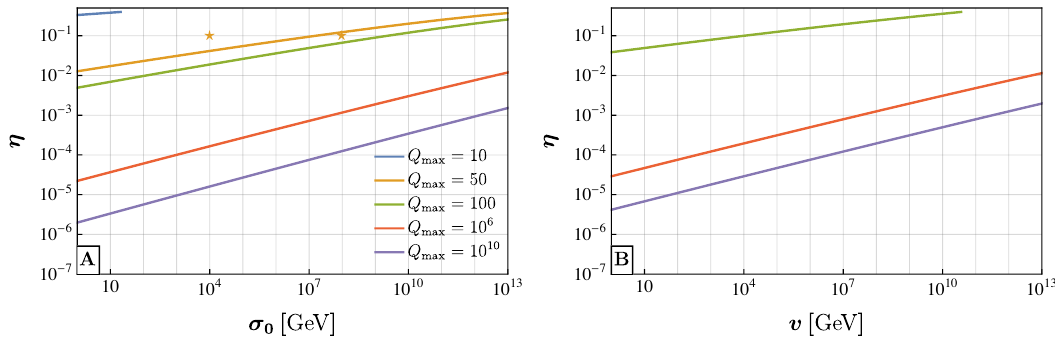
Figure 4 . The contours of T D = T F for Model A (left panel) and Model B (right panel) and various Q max . For all curves, Q min = 4 . Above each curve is the parameter space where solitosynthesis can happen with Q-balls dominant over free particles in charge abundance. For the left panel, the two star symbols correspond to the two benchmark points shown in figure 3—one with “efficient” solitosynthesis and one without. Only the contours with Q max = 100 , 10 6 , and 10 10 are shown in the right panel due to the plot